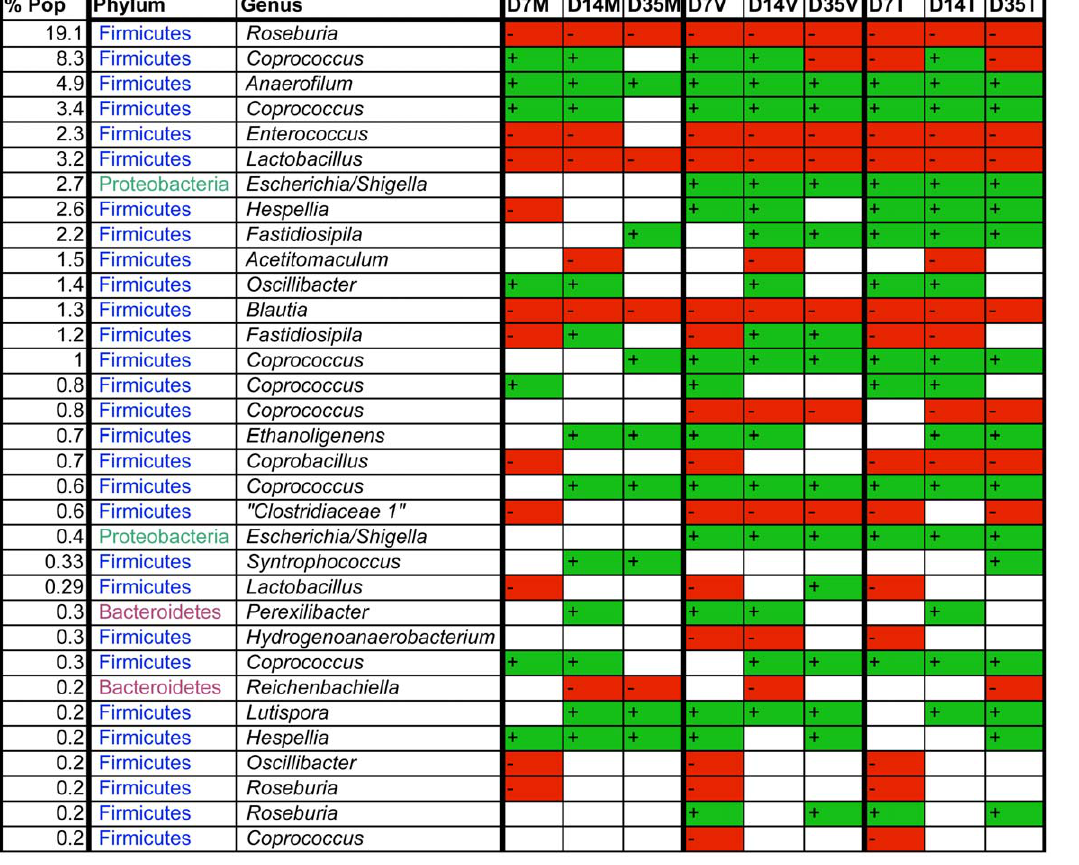
Figure 5. Most abundant OTUs identified in chicken cecum samples throughout all timepoints. Classifications of representative sequences from the OTU using RDP with their bootstrap confidence values are shown, as well as if an OTU was significantly enriched (green) or depleted (red) compared to the control group for that timepoint (p , 0.05). For each timepoint (D7, D14, and D35), C = control diet, M = monensin treatment, V = monensin/virginiamycin treatment, and T = monensin/tylosin